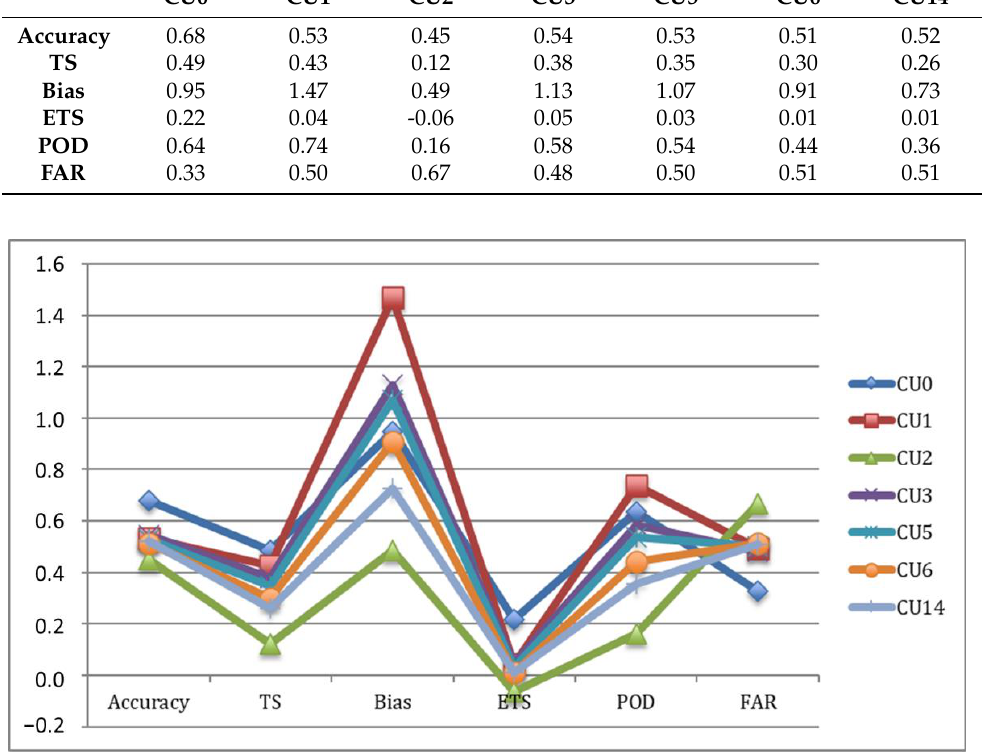
Figure 11. Graphic of indexes calculated for each simulation performed by modifying the physical parameterization of the convective processes of the WRF model. It shows that the CU0 (blue line) was the most reliable and accurate solution. The CU2 (green line) was the worst. CU1 (red line), CU3 (violet line), and CU5 (light blue line) were the only schemes that tended to overestimate the rain. The CU14 and the CU6 (orange line) schemes were only slightly better than the CU2.